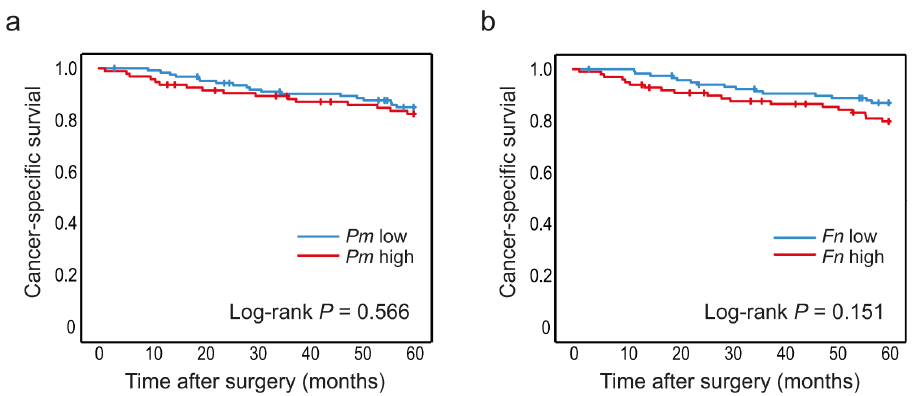
Figure 3. Levels of P. micra and F. nucleatum in tumour tissue in relation to CRC patient survival. Kaplan–Meier plots of 5-year cancer-specific survival for patients with high or low levels of ( a ) P. micra and ( b ) F. nucleatum in tumour tissue. Log-rank tests were used to calculate p values.